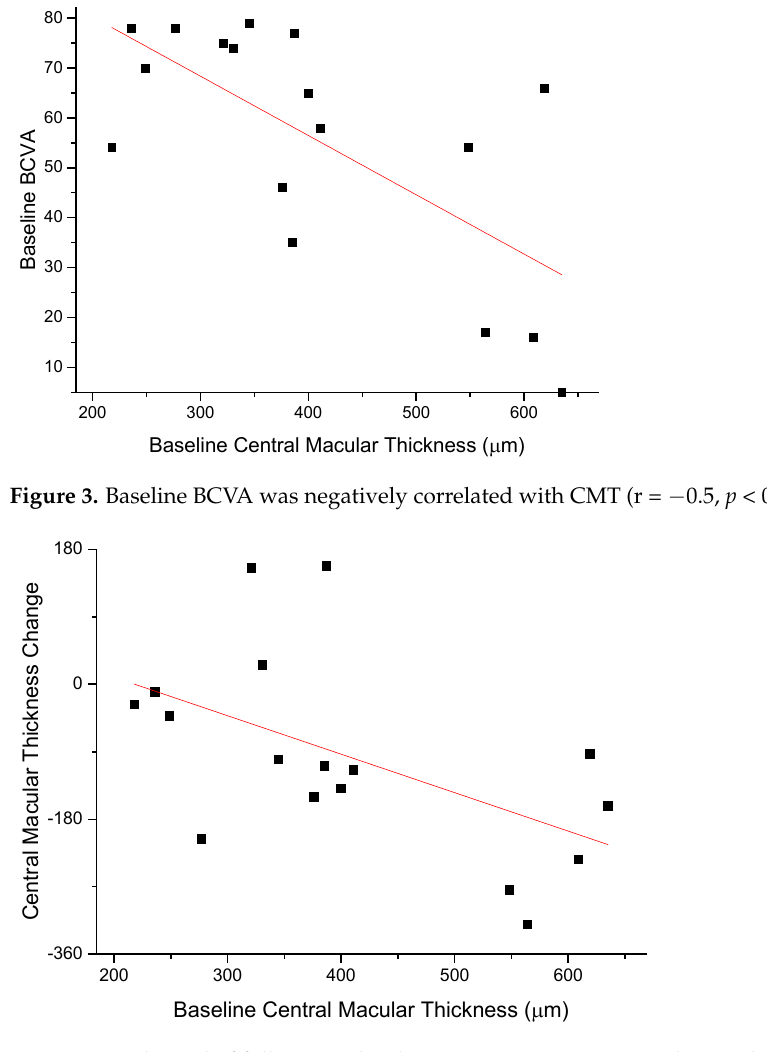
Figure 2. Baseline PhNR amplitude was negatively correlated with CMT (r = −0 .7, p < 0.01).